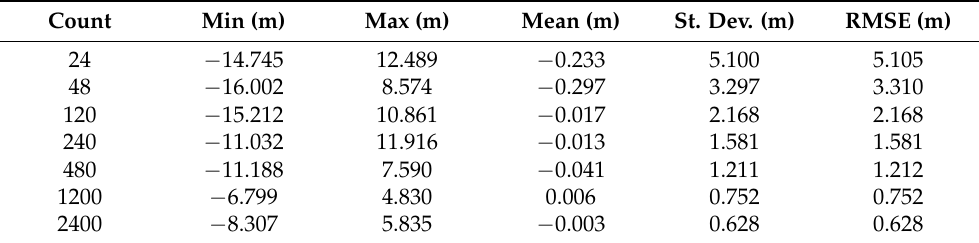
Table 3. Statistical terms of the residuals supplied by cross-validation for the Universal Kriging.